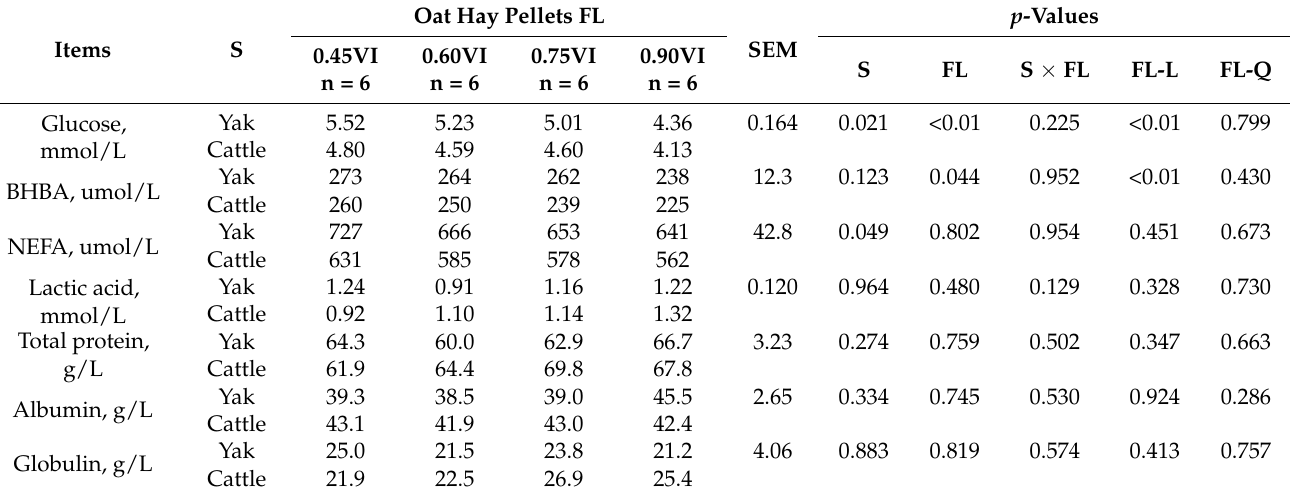
Table 5. The concentrations of serum metabolites in yaks and in cattle offered oat hay pellets at different feeding